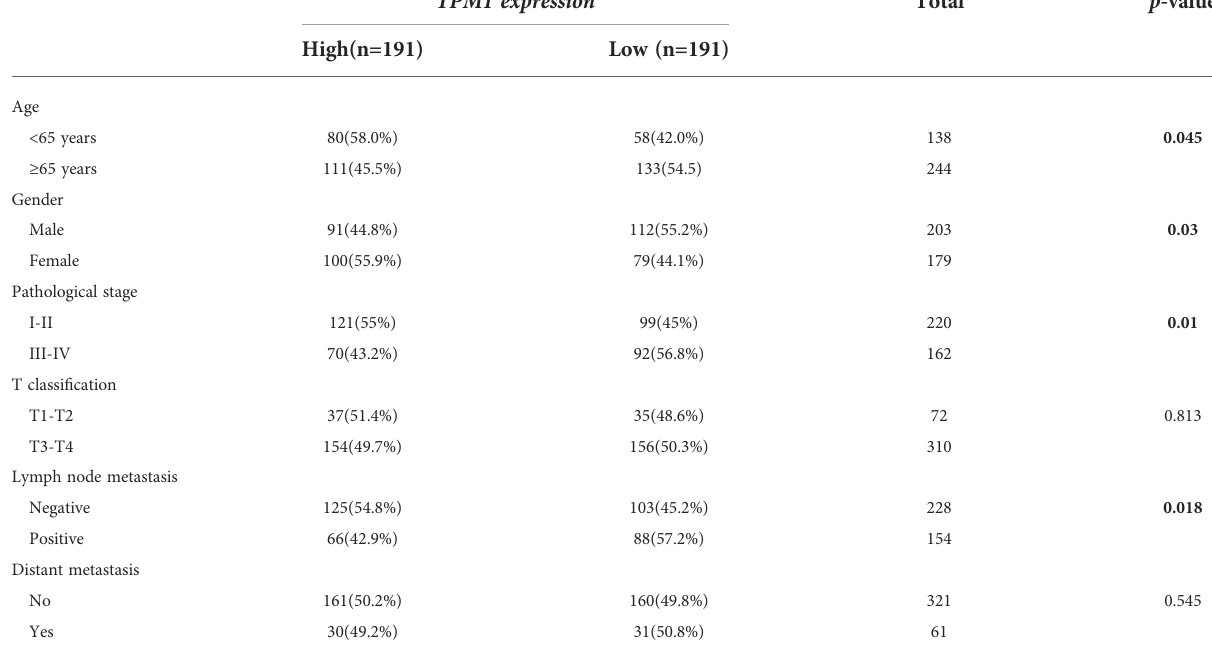
TABLE 2 Correlation analysis of TPM1 for clinical factors.